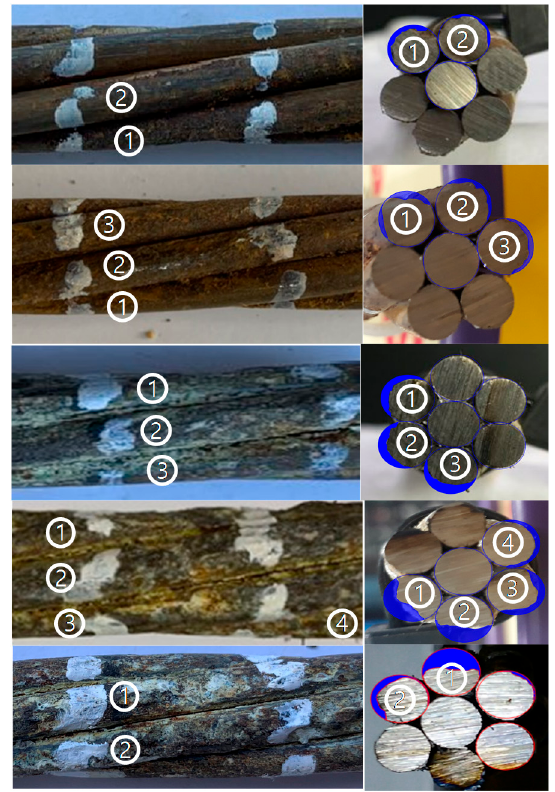
Figure 3. Corrosion of a strand near the anchor in Bridge B.